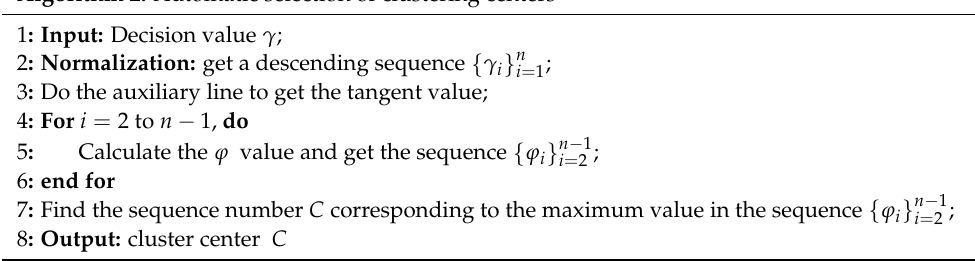
Algorithm 2: Automatic selection of clustering